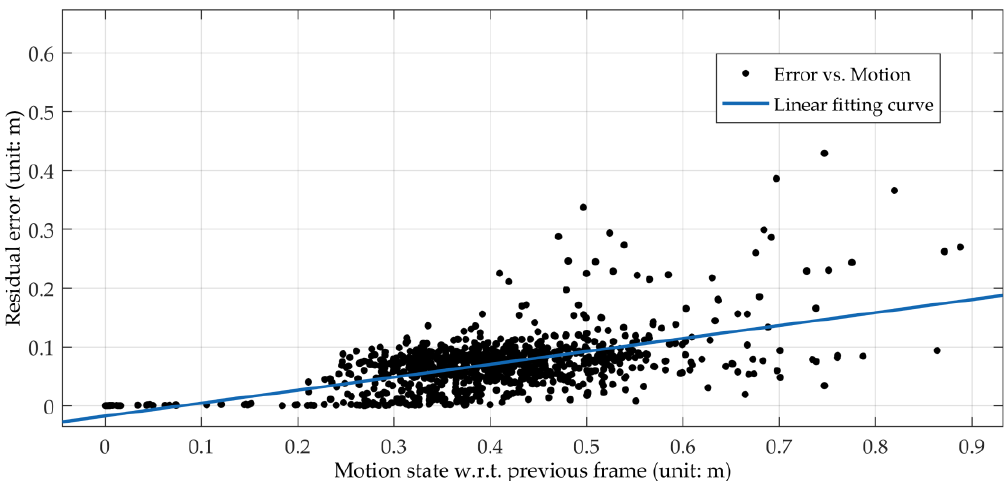
10 of 21 The color solid lines represent the accuracy of the trajectories. A change in color from blue to red indicates a gradual increase in the positioning error. We use the relative pose error (RPE) as the evaluation metric, which describes the error between pairs of timestamps in the estimated trajectory file. Then we calculate the average RPE at these two big turns A and B to represent the average drift rate between the estimated trajectory and ground-truth. As shown in Table 1, the average RPE of our extended error model is less at A and B than that of traditional error model, meaning that our proposed error model has less drift rate at A and B. This also shows that proposed error model has good robustness at large turns. More detailed results will be given in the experimental results section. Table 1. Average RPE results at A and B turns of traditional error model and our proposed error